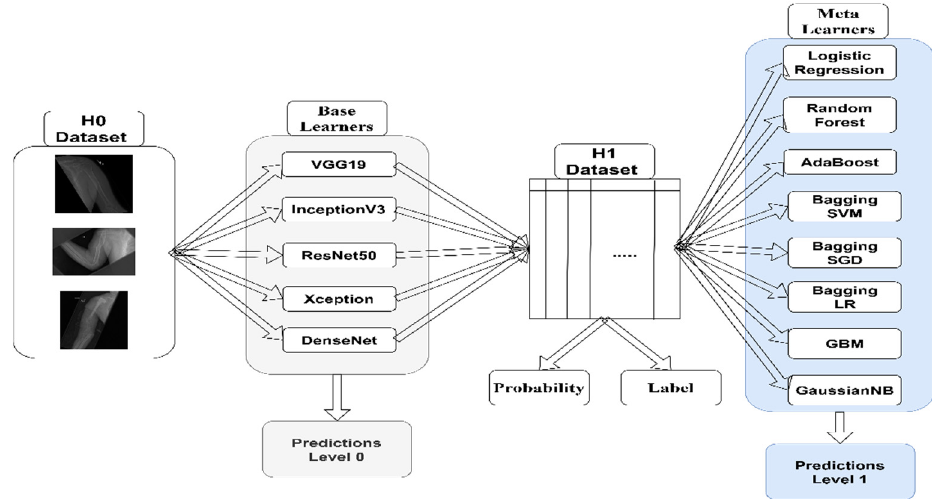
Figure 1. Schematic diagram of the proposed pipeline.